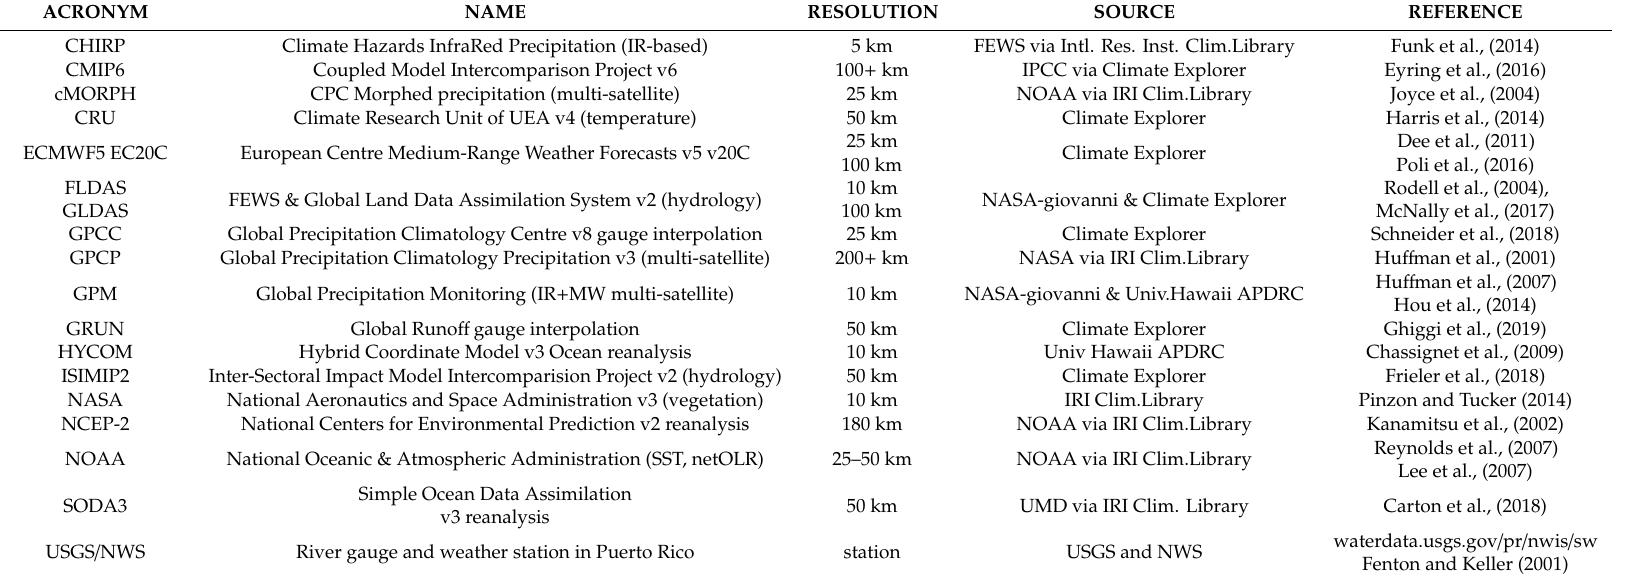
Table 1. Datasets used in the